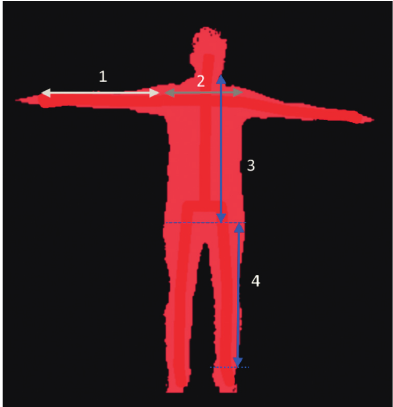
Figure 3: Lengths-(1) Arm. (2) Shoulder. (3) Neck-hip. (4)